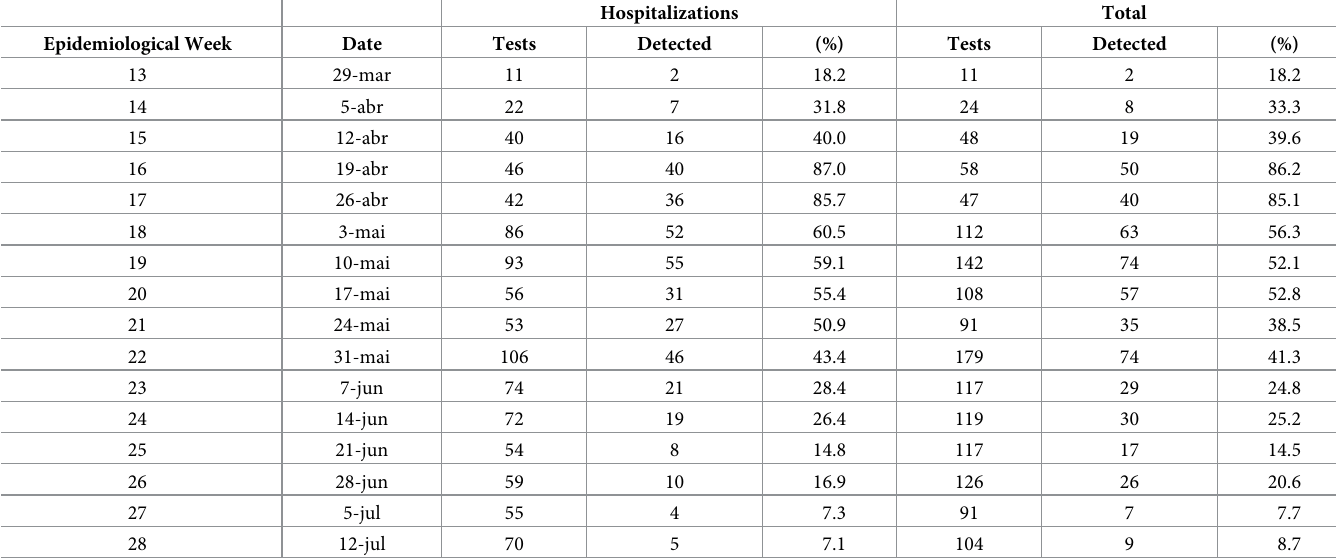
Table 2. The number of detected new and total tests at Pedro Ernesto University Hospital from epidemiological week 13 to